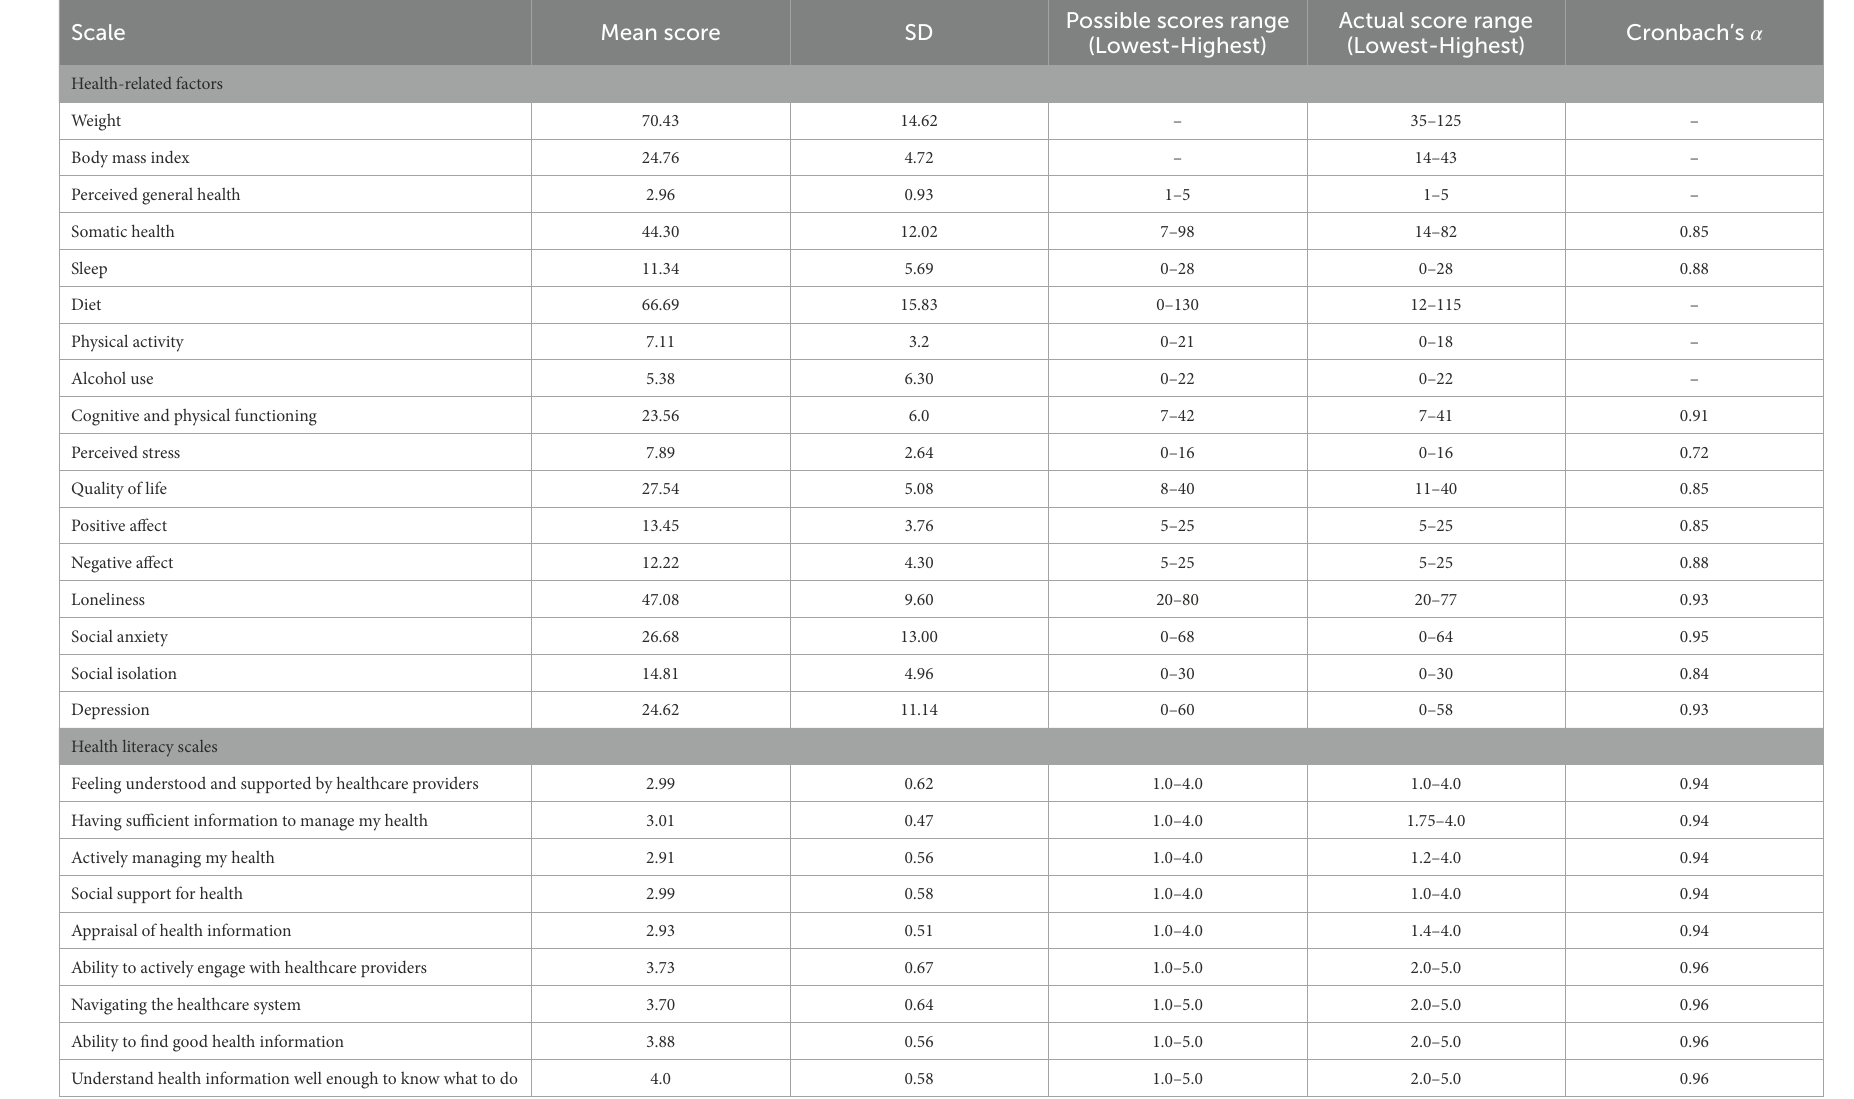
TABLE 1 Descriptive statistics and internal reliability (Cronbach’s α )